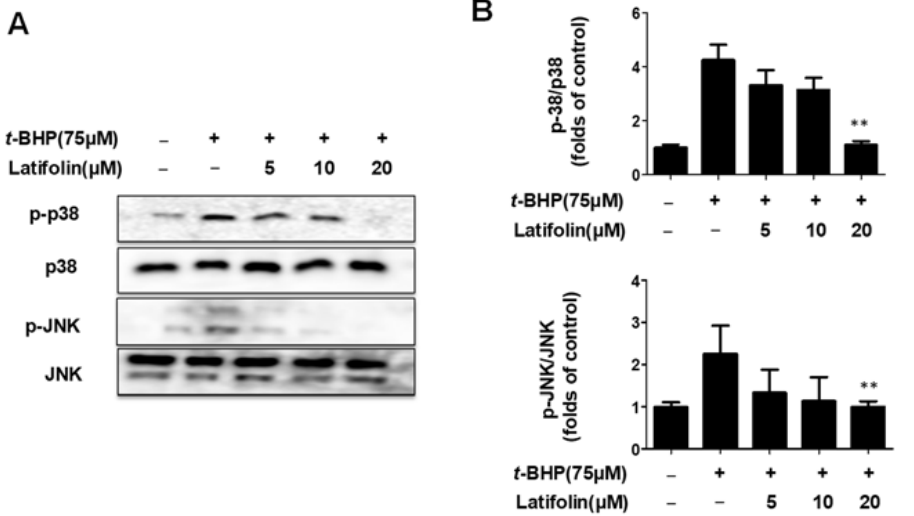
Figure 7. Effects of latifolin on MAPK signaling pathways in BJ-5ta cells ( A , B ). The data are repre- sented as the mean ± SD ( n = 3). ** p < 0.01 vs. t -BHP-treated group.